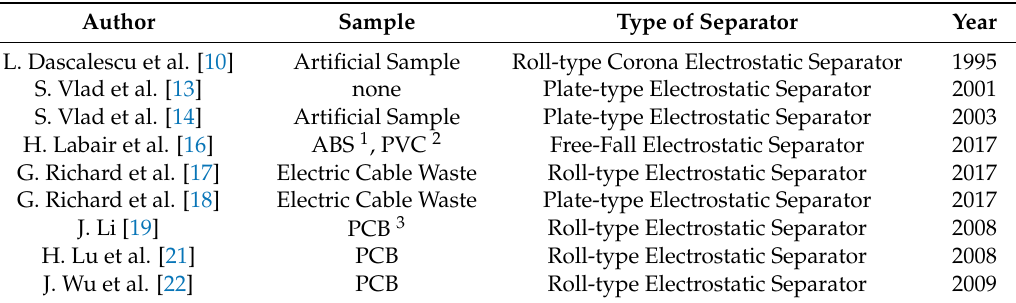
Table 1. Previous research on particle